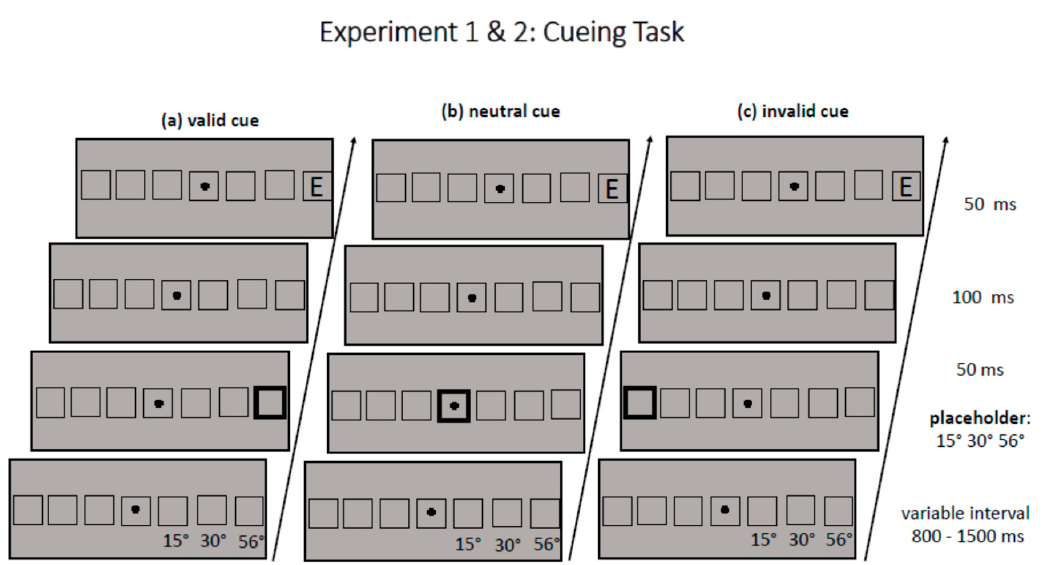
Figure 1. The figure shows the sequence of ( a ) validly, ( b ) neutrally, and ( c ) invalidly cued trials for Experiments 1 & 2, with the exception that the medium placeholder was presented at 35° in Experiment 2. Note that the distance between the placeholders is not drawn to